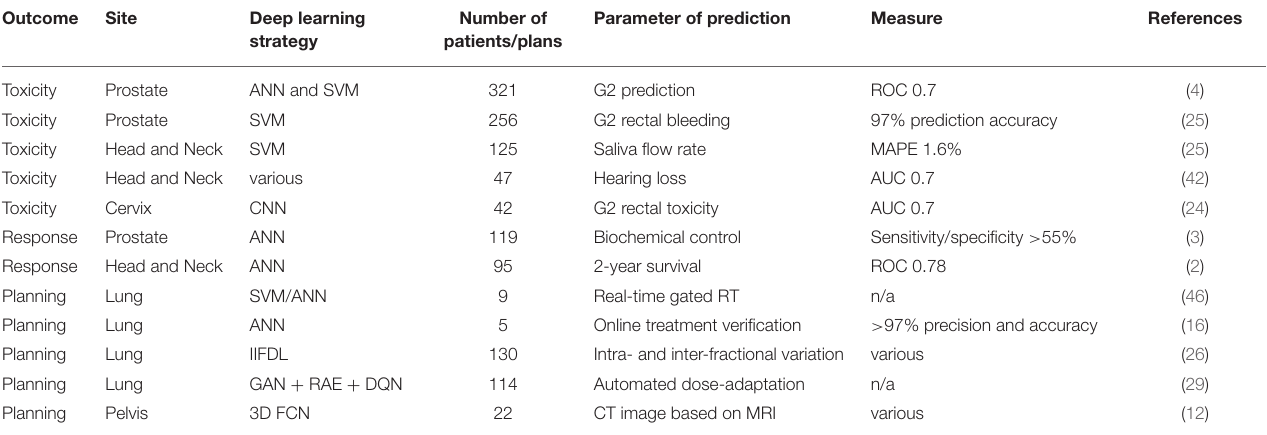
TABLE 1 | Deep Learning for clinical applications in toxicity and outcome prediction as well as treatment planning. Outcome